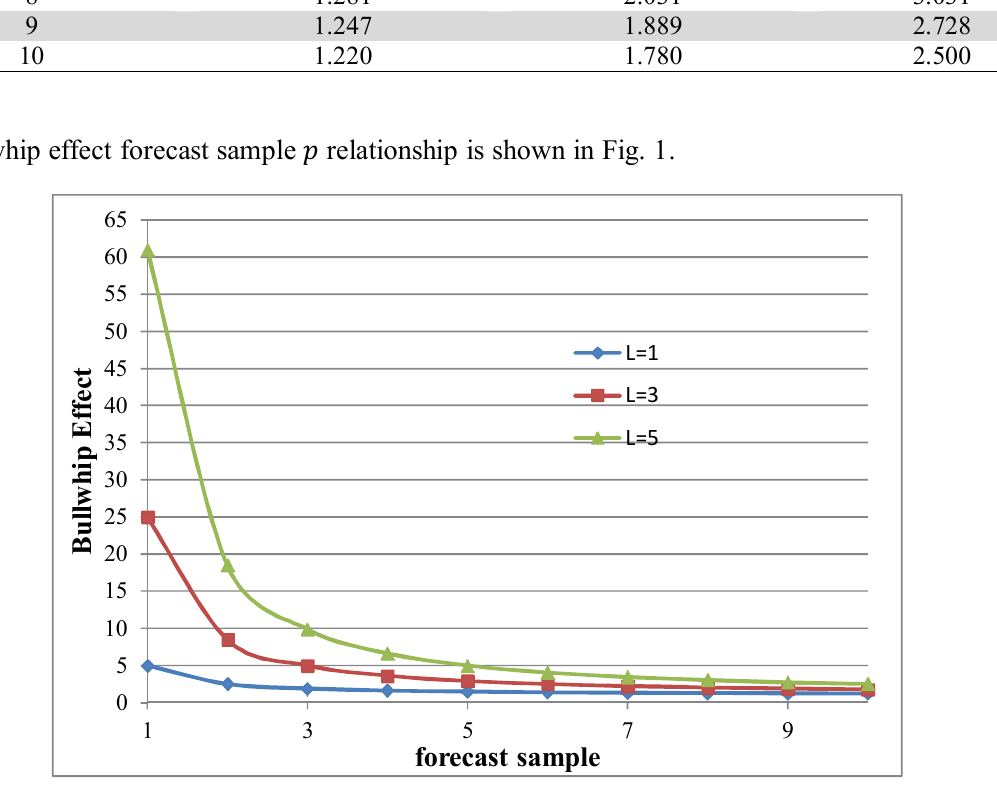
Fig. 1. Forecast sample